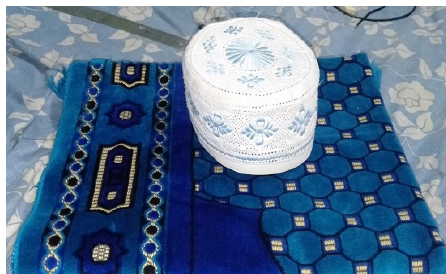
Figure 15. Alt-text: A white and blue embroidered prayer cap on a blue patterned prayer mat.